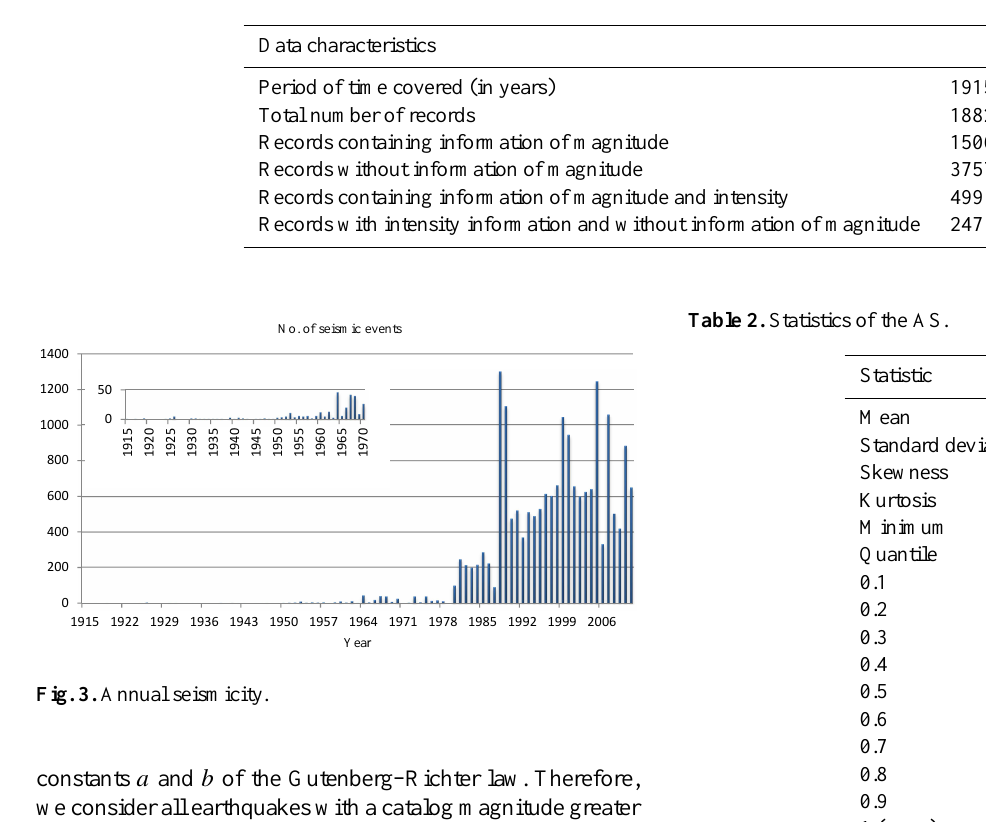
Table 1. Data characteristics.